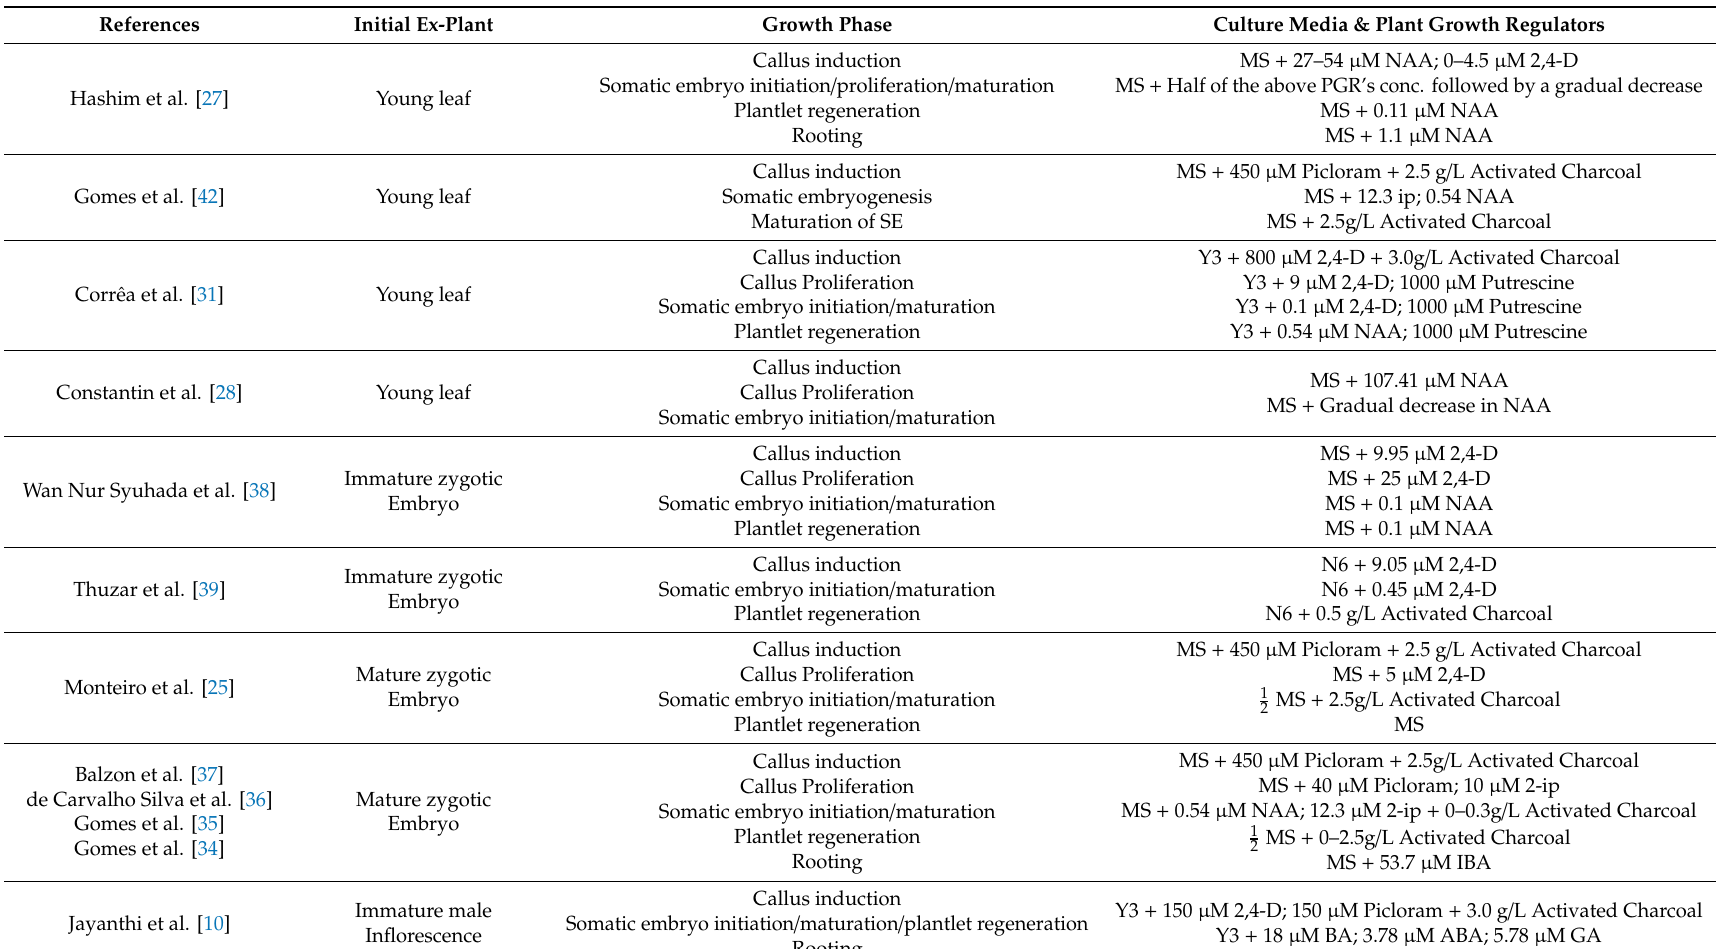
Table 1. In vitro regeneration of oil palm via somatic